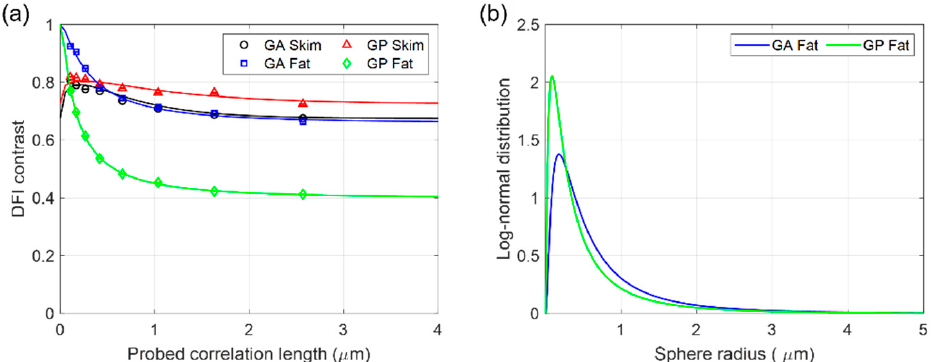
Figure 7. ( a ) Dark-field contrast of the deuterated milk gels over probed correlation length. The solid lines represent fits by projected real-space correlation functions. The fractal network model was fitted to the skim rennet gel (GP Skim) and the skim acidified gel (GA Skim), and a polydisperse interacting the hard-sphere model was used to model the FG in the reduced rennet gel (GP Fat) and the acidified gel (GA Fat) data. ( b ) The modelled log-normal size distribution of FG in the fat milk gels. (Color in online). Table 4. Structural parameters and goodness of fits for the fractal network of casein micelles (CM) in the deuterated skim milk gels.